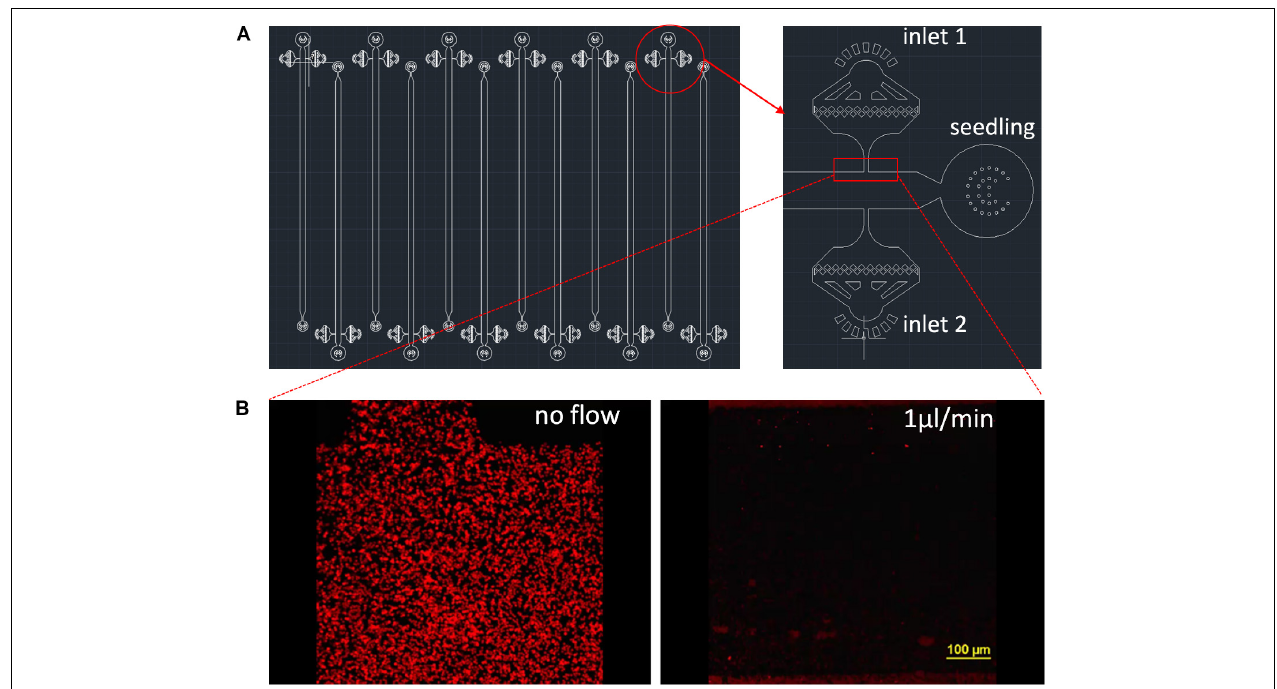
FIGURE 1 | RMI-chip design. (A) The CAD design of the RMI-chip. A single growth channel is 36 mm long, 100 µ m high, and 800 µ m wide (A) . The media and inoculation inlets are equipped with on-chip filters to avoid occlusions during week-long experiments. Design files are available in the online supporting materials. (B) Flow dynamics. Fluorescently labeled latex beads were used to measure media flow in the empty RMI-chip. The root entrance and the inoculation inlets were plugged with stopper pins to mimic operational flow regime of the chip. The latex beads suspended in Johnson’s were injected and the chip was imaged without and with perfusion with Johnson’s solution at 1 µ L/min. The latex beads were washed from the upstream chambers and the velocity of the beads were averaged. The measured and calculated values agreed. Laminar flow was observed under the microscope.